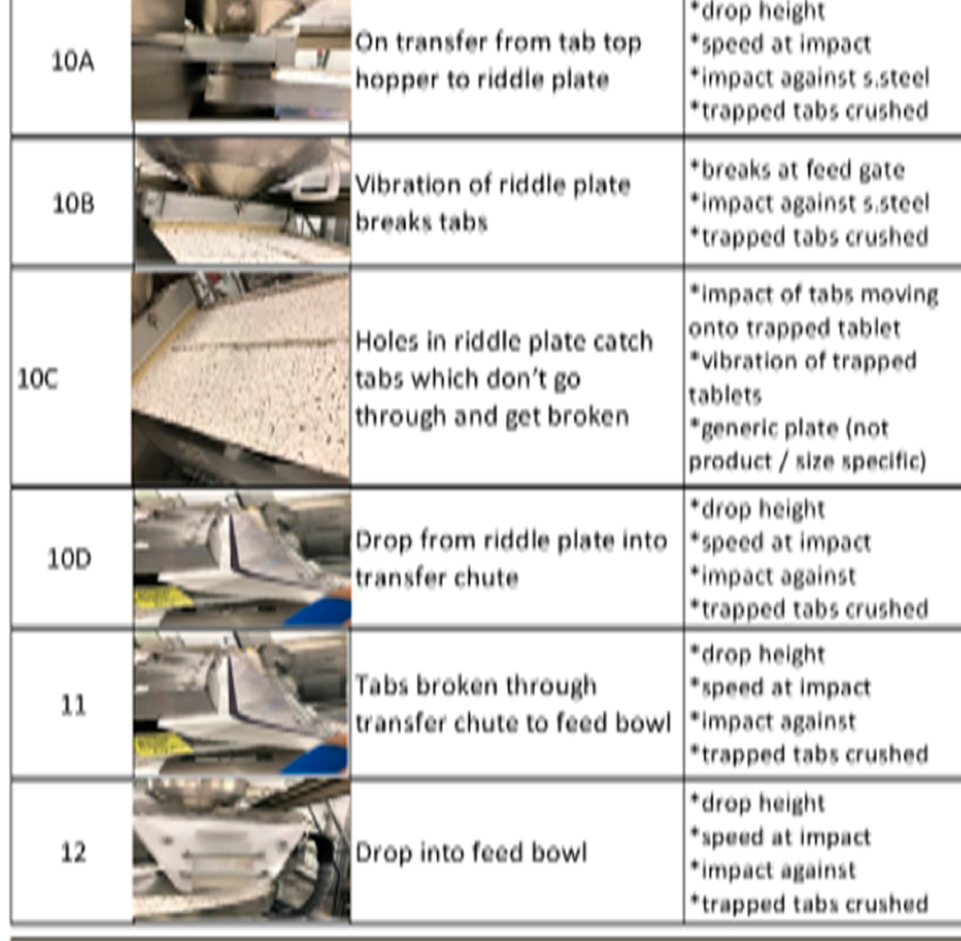
eration tool. The principal of operation analysis resulted in an understanding that the upper hop- per gravity feeds down onto the riddle plate. The shape of the hopper creates a vortex- type action creating pressure on the tablets within this stainless-steel unit—effectively, it resembles sand flowing through an egg timer. There is a window on the side of the hopper and upon observation shows that the tablets on the outside area of the hopper move last; the tablets in the center of the hopper get pulled down first thus creating pressure on the tablets.